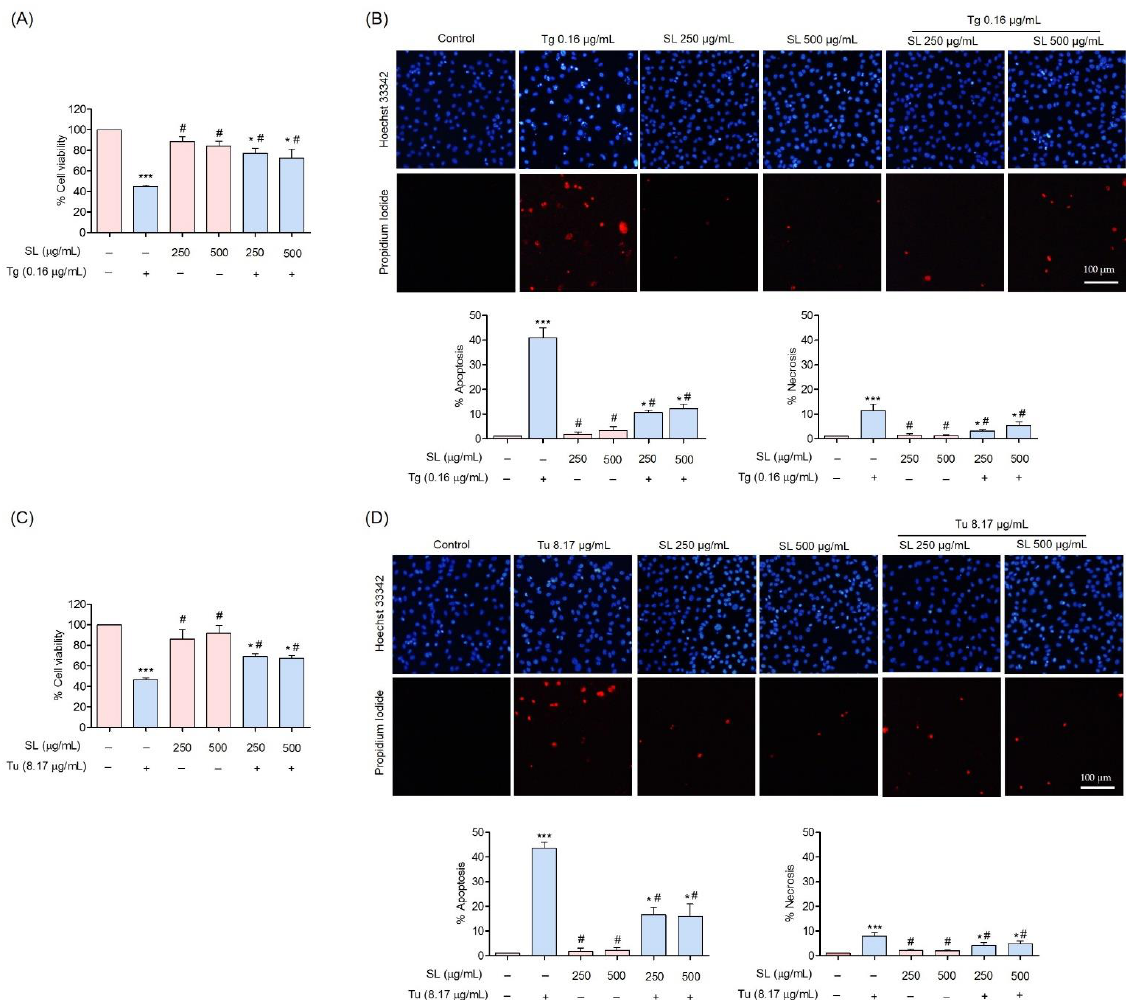
Figure 4. Cytoprotective effect of SL against ER stress in EA.hy926 cells. ( A , C ) The cytoprotective effect of SL on EA.hy926 cells against ERstress-induced toxicity was investigated using an MTT assay. ( B , D ) Morphology of apoptotic nuclei stained with Hoechst 33342 dye and propidium iodide (PI) in cells treated with SL and ER stress inducers (Tg and Tu), visualized by fluorescence microscopy and calculated for percentages of apoptosis and PI-positive cells. Data are presented as mean ± SD ( n = 3). * p < 0.05 and *** p < 0.001 versus the control group and # p < 0.05 versus the Tg-treated